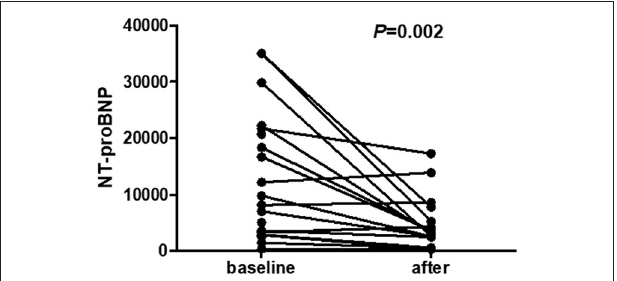
FIGURE 2 | NT-proBNP levels of PD patients before and after initiating sacubitril-valsartan with an observation period of 3–12 months. Wilcoxon matched-pair signed-rank (two samples) tests were applied to compare self-matching data on NT-proBNP. Results show that compared with baseline levels, NT-proBNP levels are markedly decreased after treatment with sacubitril-valsartan [9769.0 (3093.5–21941.0) vs. 3034.0 (1493.2–6503.0), P =